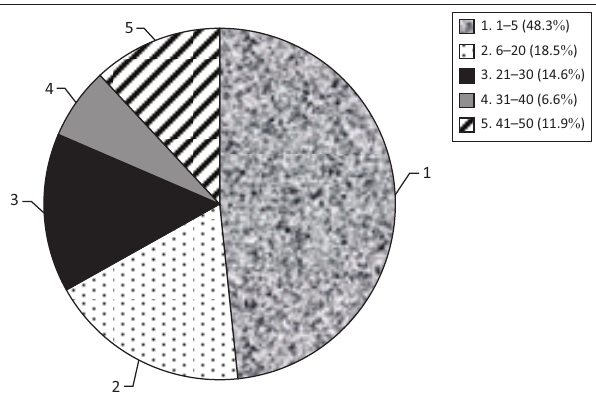
FIGURE 8: Number of employees in the